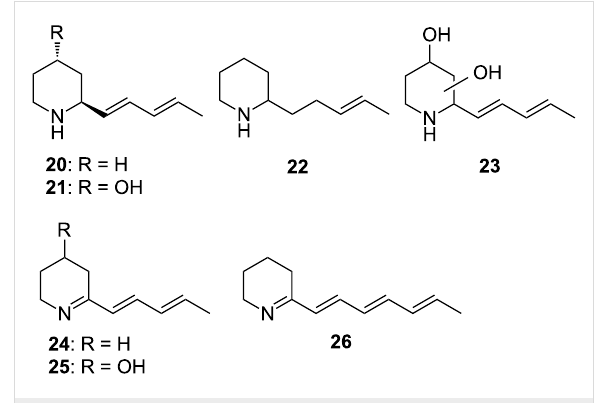
Figure 5: Structures of piperidine derivatives 20 – 26